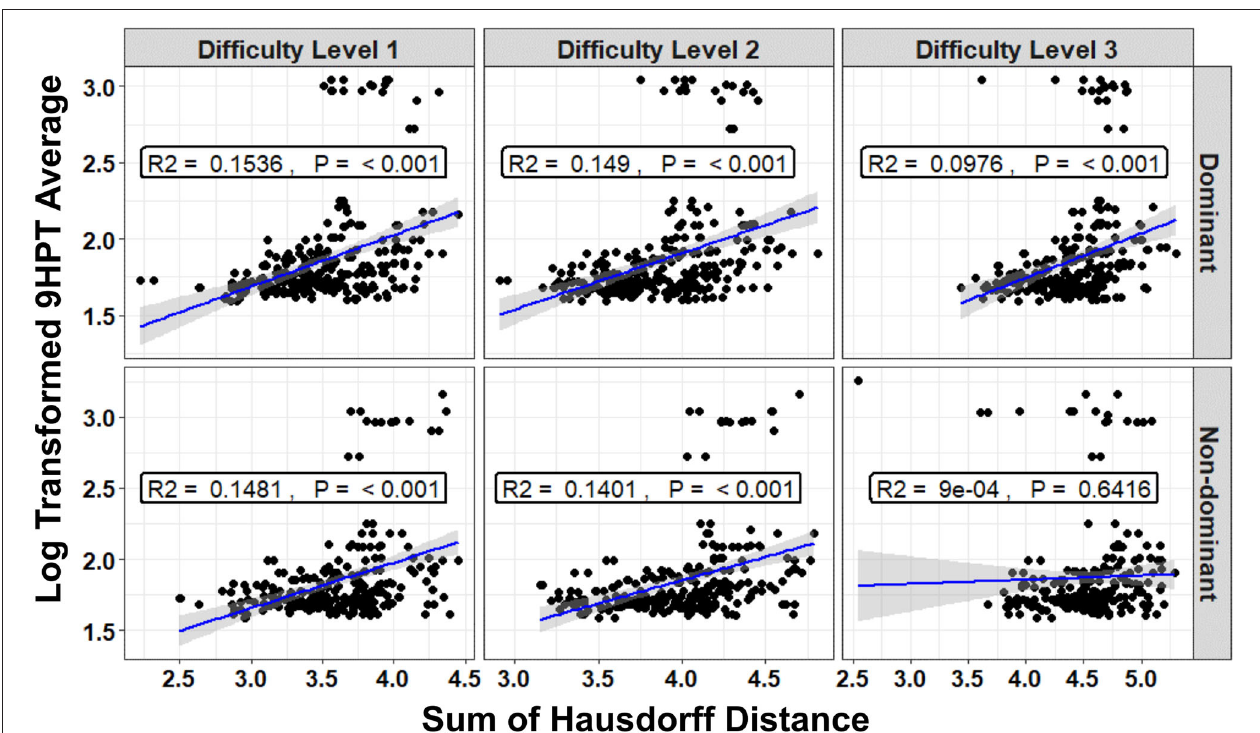
FIGURE 10 | Relationship between the sum of the Hausdorff distances and the 9HPT average (in seconds) of the MS cohorts in black dots. Regression lines are shown in solid blue line while the gray shaded area constitutes the 95% confidence interval associated with the mean model’s prediction (The R2 indicates the percent of the variance in the 9HPT average that can be explained by the sum of Hausdorff distances. P is the model’s p